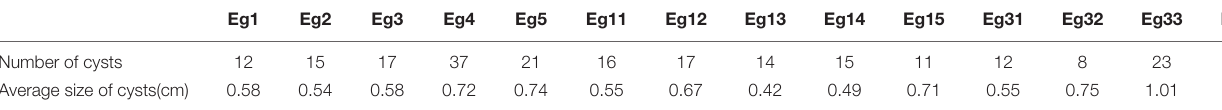
TABLE 1 | The number and average size of cysts in the E. granulosus infection group.